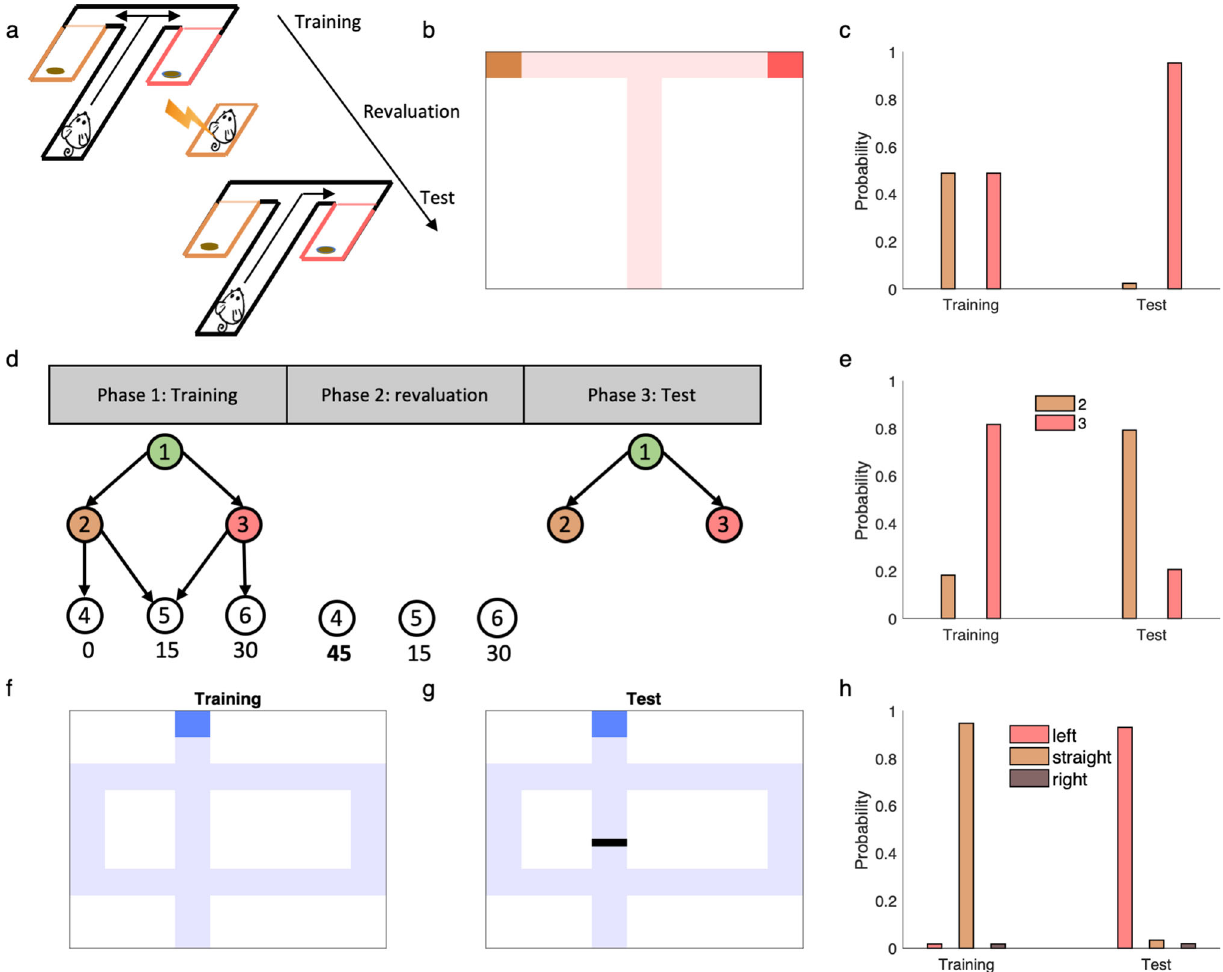
Fig. 3 Linear RL can explain fl exible replanning. a – c Performance of linear RL on a version of Tolman ’ s latent learning task ( a ). We simulated the model in a maze representing this task ( b ) and plotted the probability of choosing each end-box during the training and test phases. The model correctly ( c ) reallocates choices away from the devalued option. d , e Performance of linear RL in another reward revaluation task 5,6 , termed policy revaluation ( d ). Choices from state 1: during the training phase, the model prefers to go to state 3 rather than state 2. Revaluation of the bottom level state reverses this preference ( e ) similar to human subjects 6 . f – h Performance of the model in Tolman ’ s detour task. The structure of the environment changes in this